Question: Is the quantity shown trending increasing or decreasing?
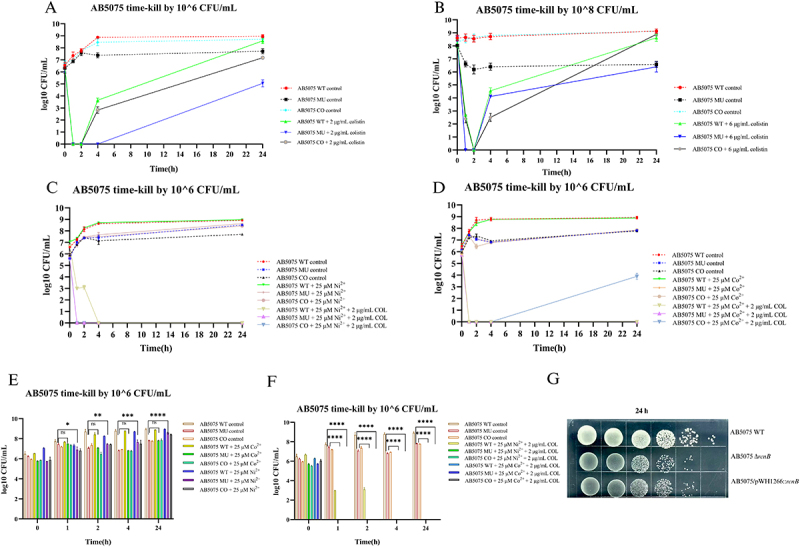
Answer: increasing